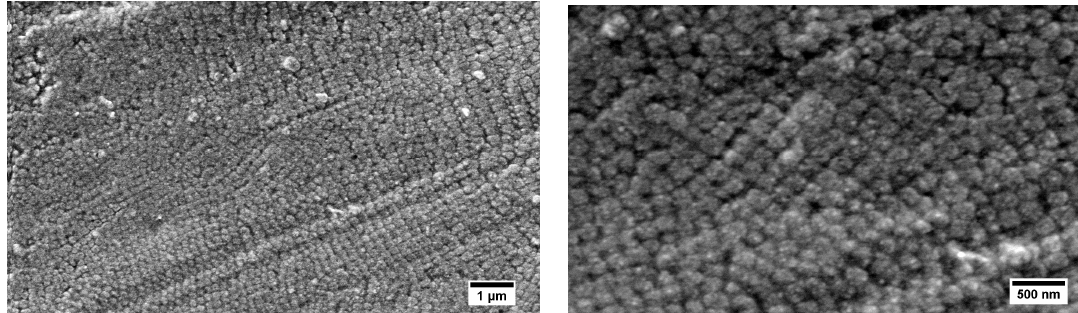
Figure 11. SEM images of the surface from the P(S- co -ALMA)@P(EA- co -MPSEt) film after processing at 115 °C below the crosslinking temperature.